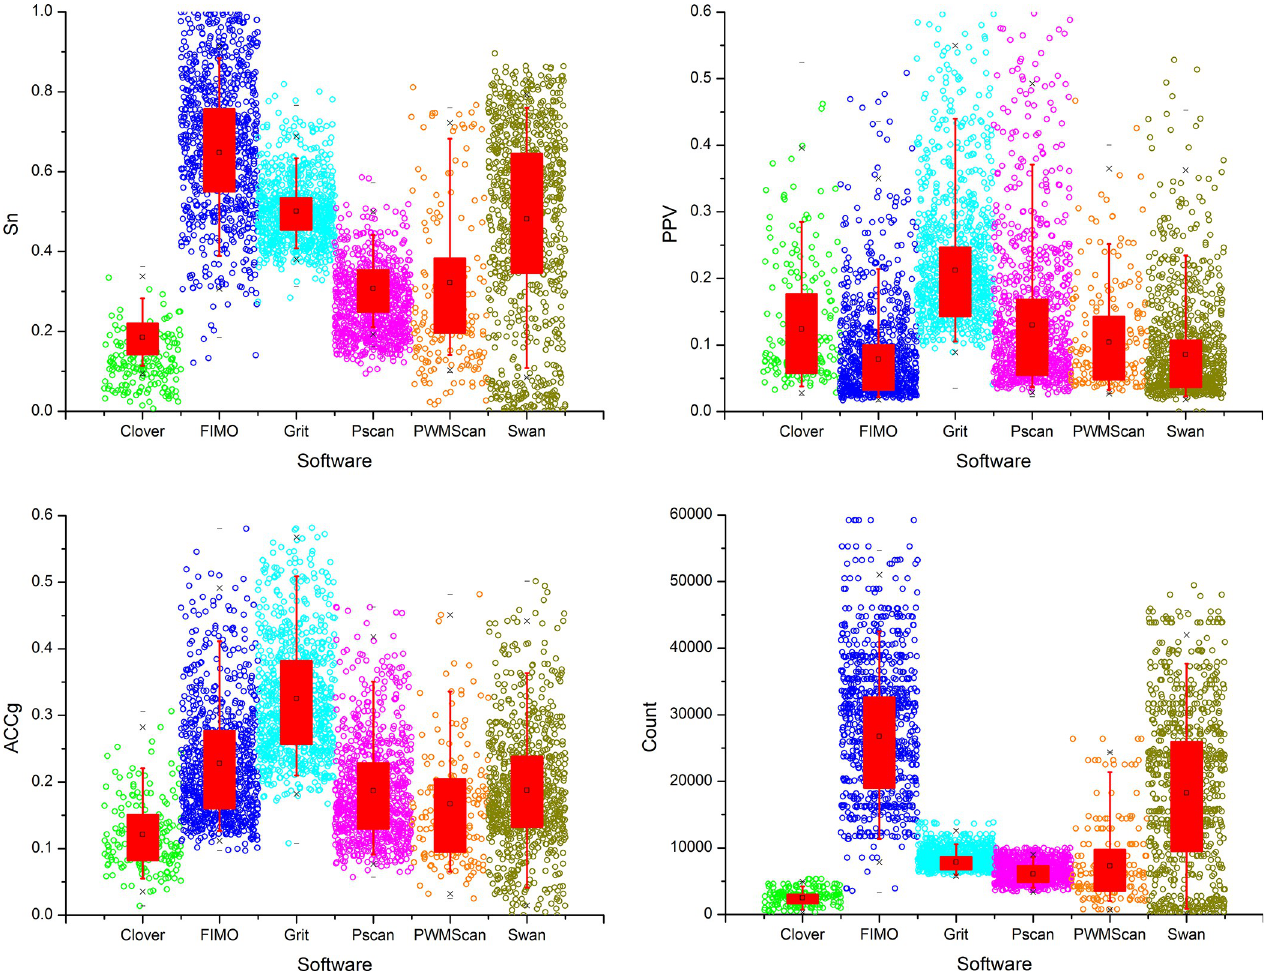
Fig 2. Performance assessment of motif scanners in analyzing ReMap datasets. A total of six scanners (Clover, FIMO, Grit, Pscan, PWMScan, and Swan) were evaluated based on the parameters of sensitivity (Sn), positive predictive value (PPV), geometric accuracy (ACCg), and total number of predicted transcription factor binding sites (TFBS,